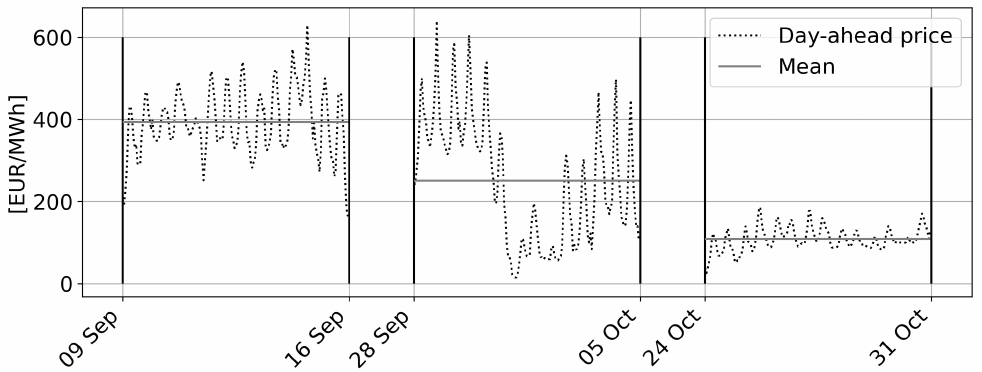
Figure 3. Representation of the scenarios based on the history of electricity prices on the